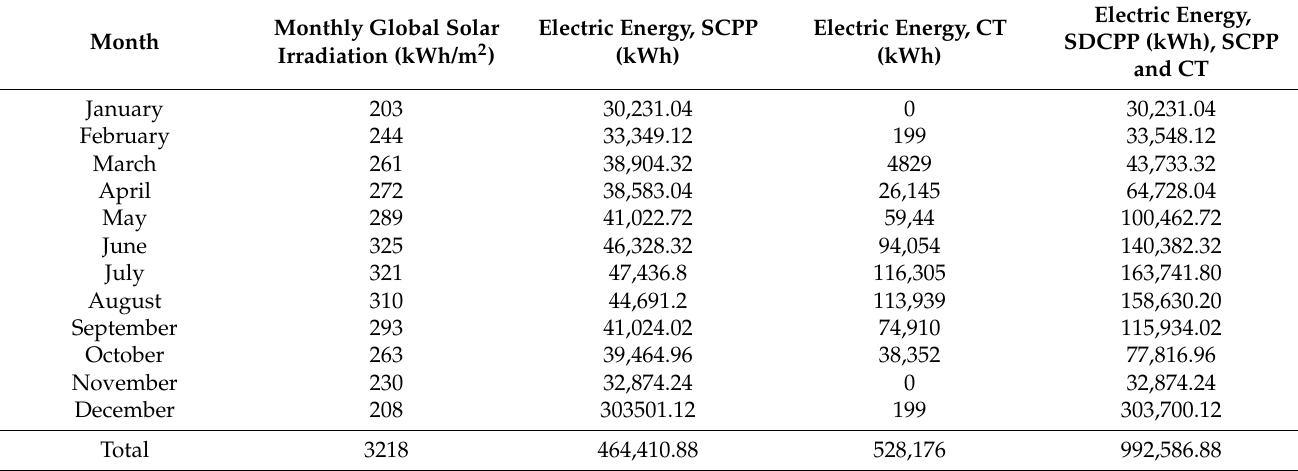
Table 4. Monthly electrical power production from the